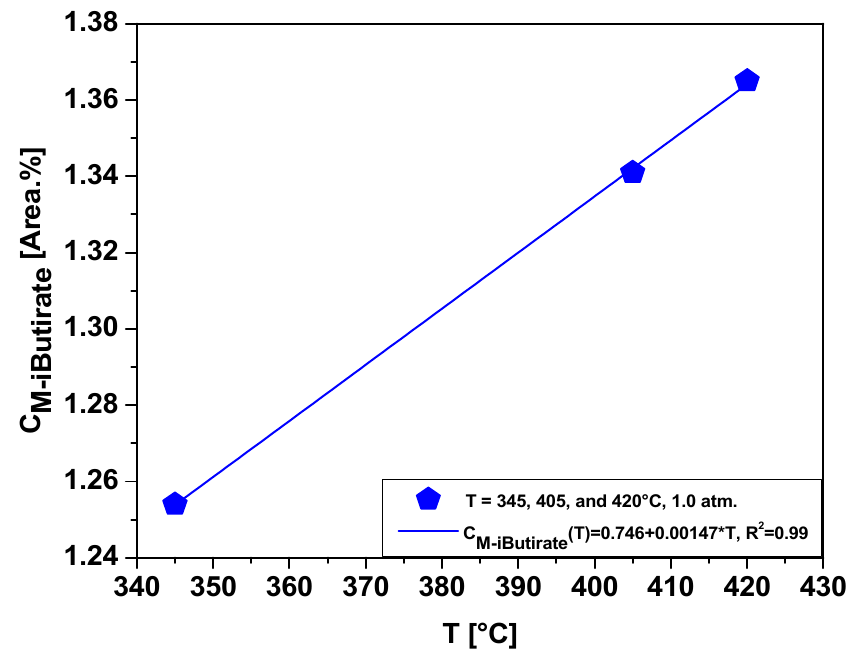
Figure 12. Concentration of methyl iso-butyrate, a side reaction product, in the liquid phase by de- polymerization of PMMA based dental resins fragments/residues at 345, 405, and 420 °C, atmospheric pressure, and 50 min.